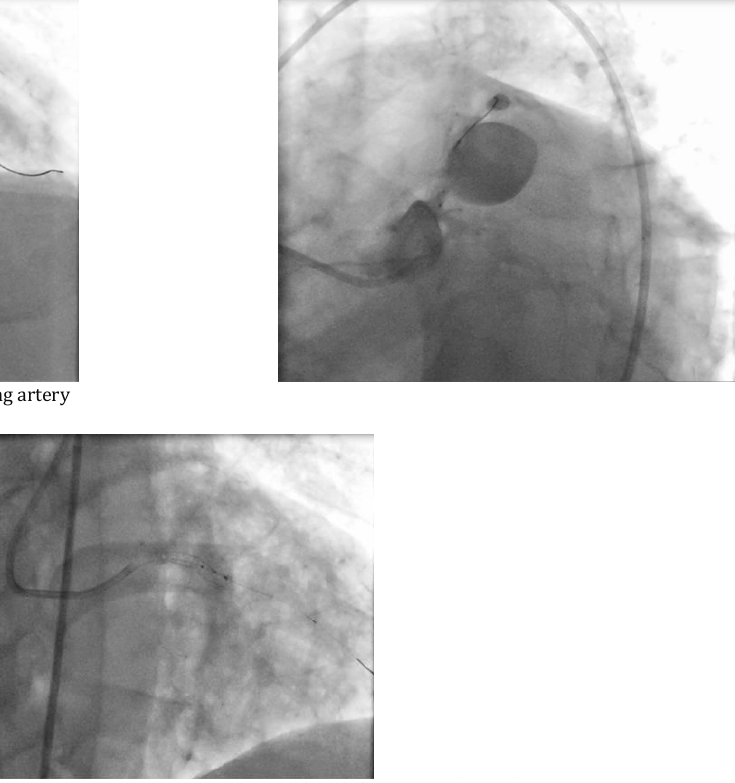
Figure 5. Graft-coated stent deployed on the proximal segment of the left anterior descending